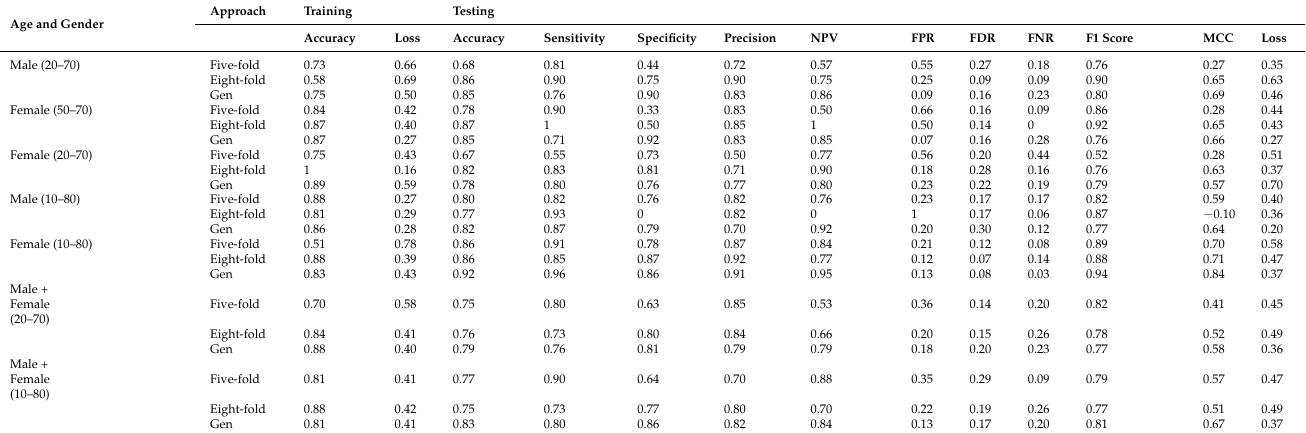
Table 10. CNN-DNN using age and gender (Gen = Generalization